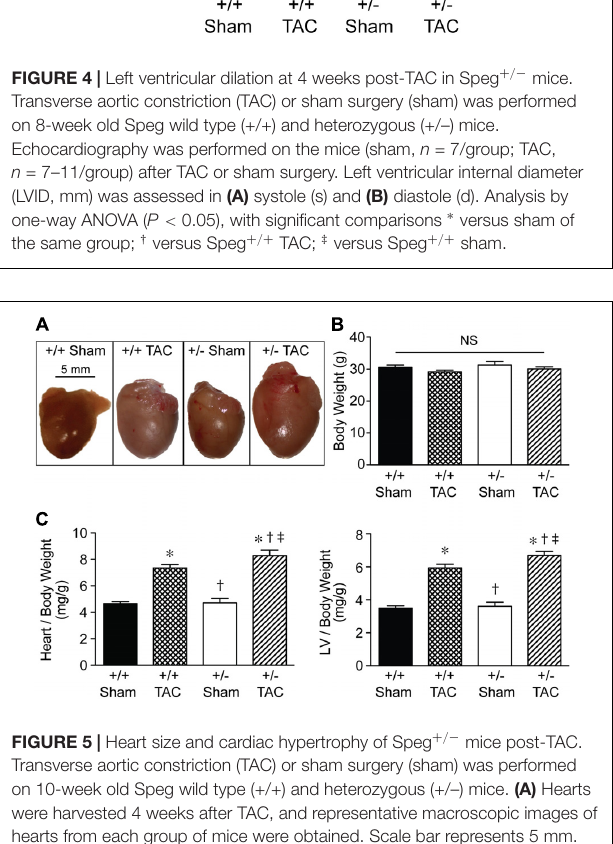
and Speg + / + hearts under normal physiologic